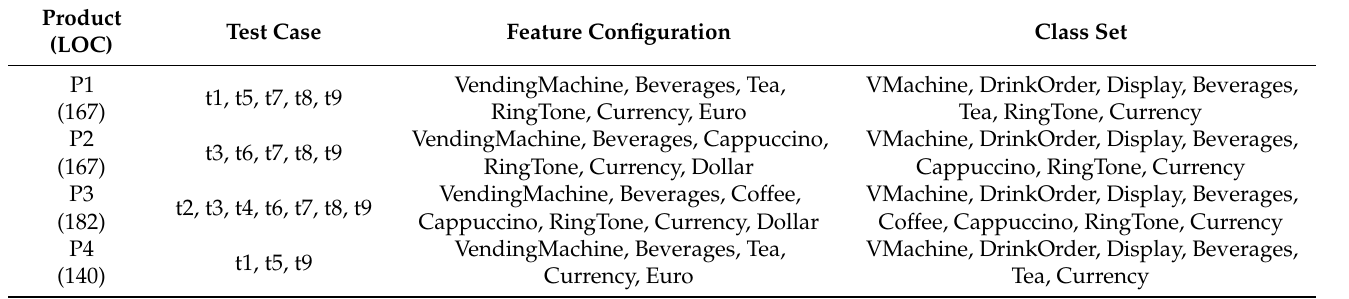
Table 3. A product family SPL V0